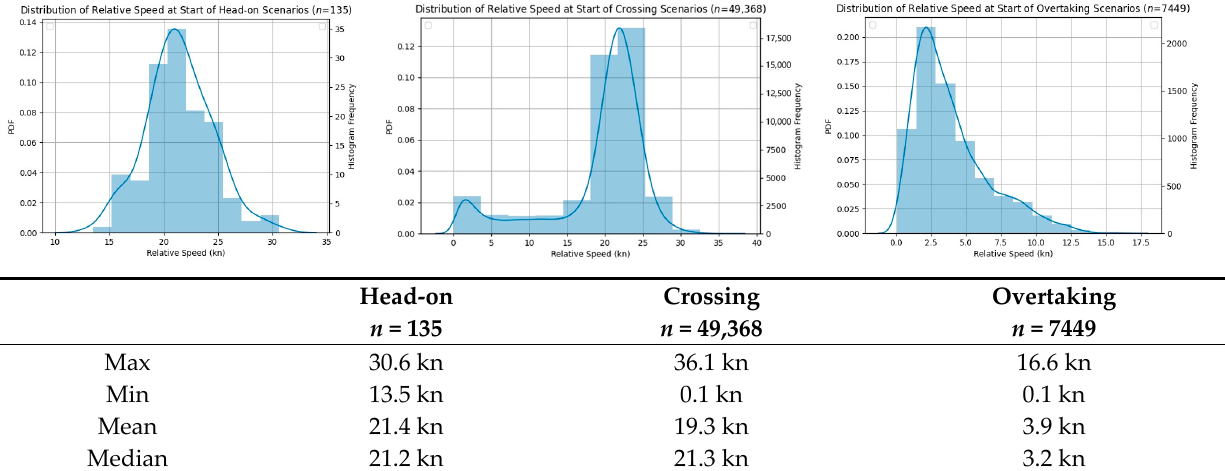
Figure 6. Distribution of relative distance at the start of different encounter scenarios. The numbers indicate how far away two ships are when the encounter situation is being initiated. Figure 7 indicates the distribution of RS at the start of different encounter scenarios.